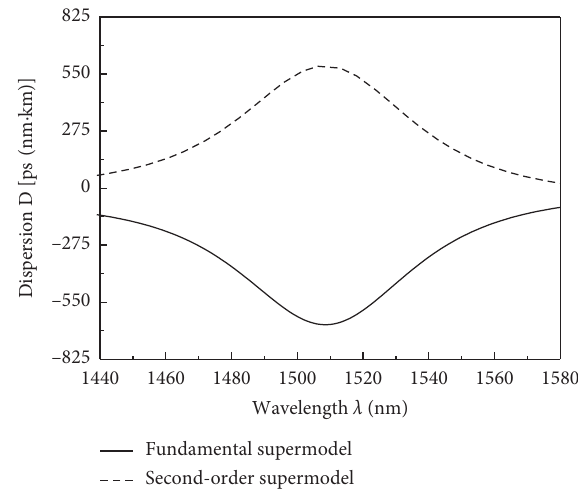
Figure 3: Large negative dispersion generated (solid line) by the fundamental supermodel and large positive dispersion (dashed line) generated by the second-order